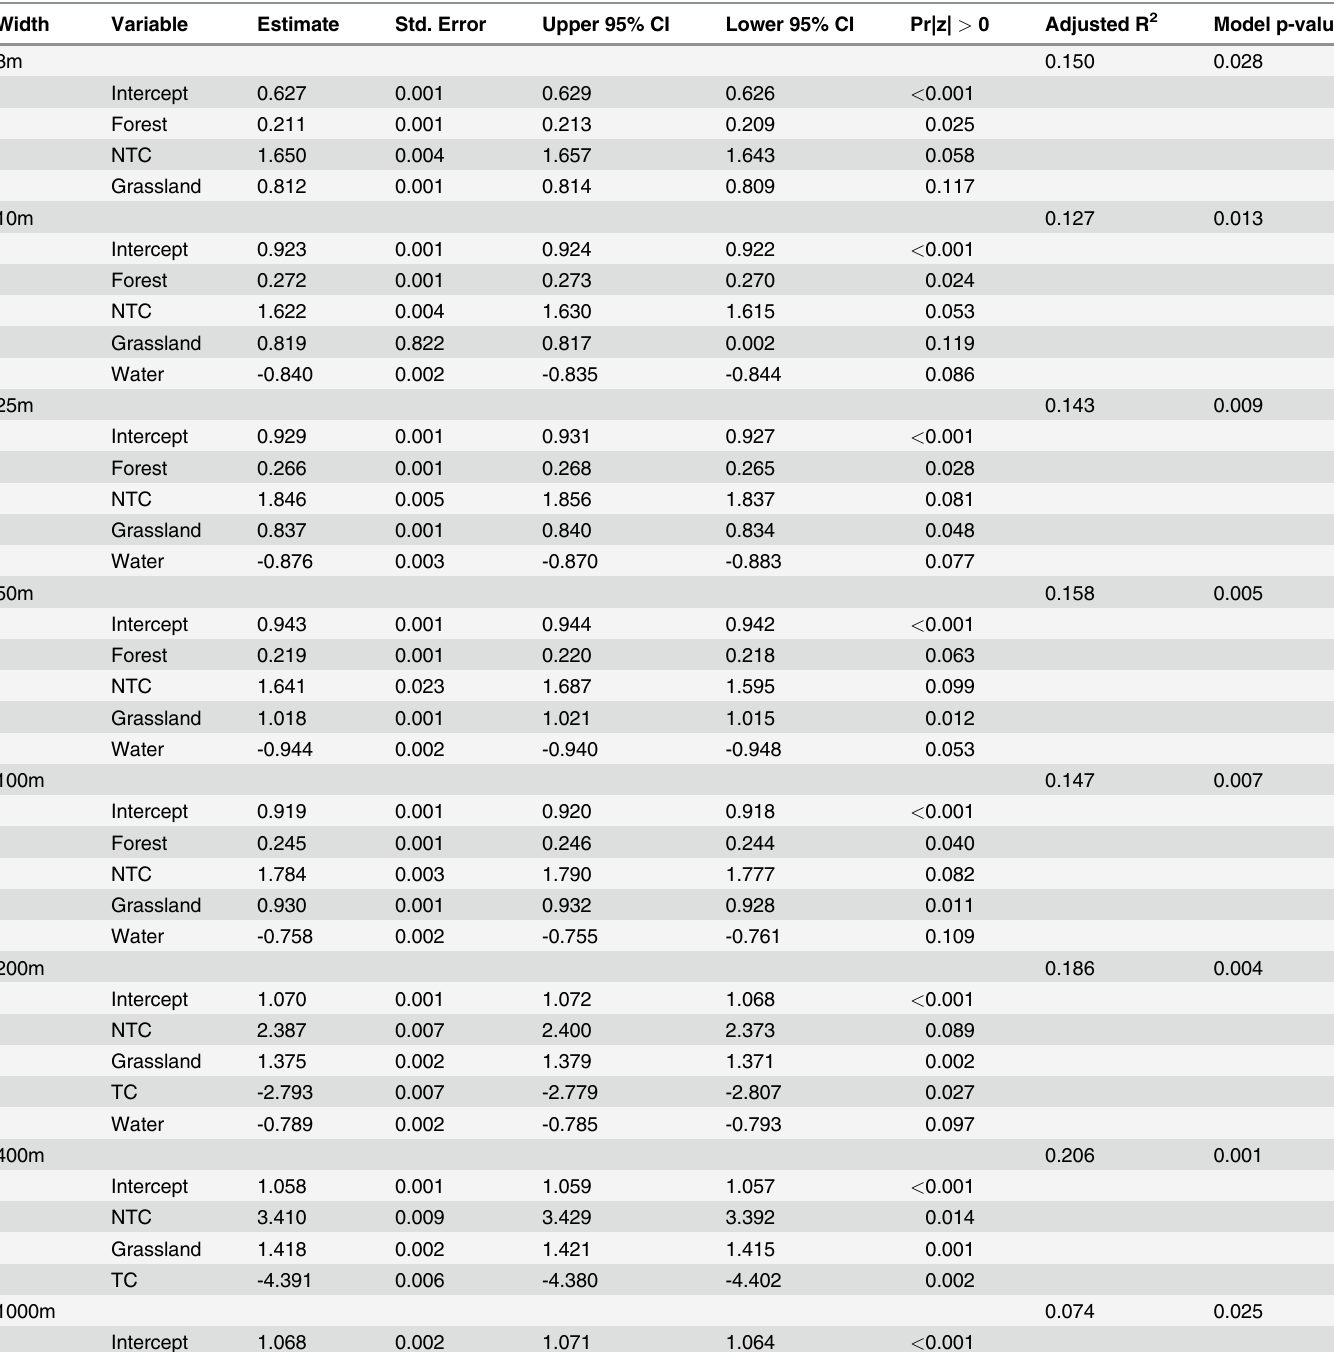
Table 2. Final multiple regression models for habitat composition prediction of probability of population membership for eastern chipmunks collected in northern Indiana after stepwise